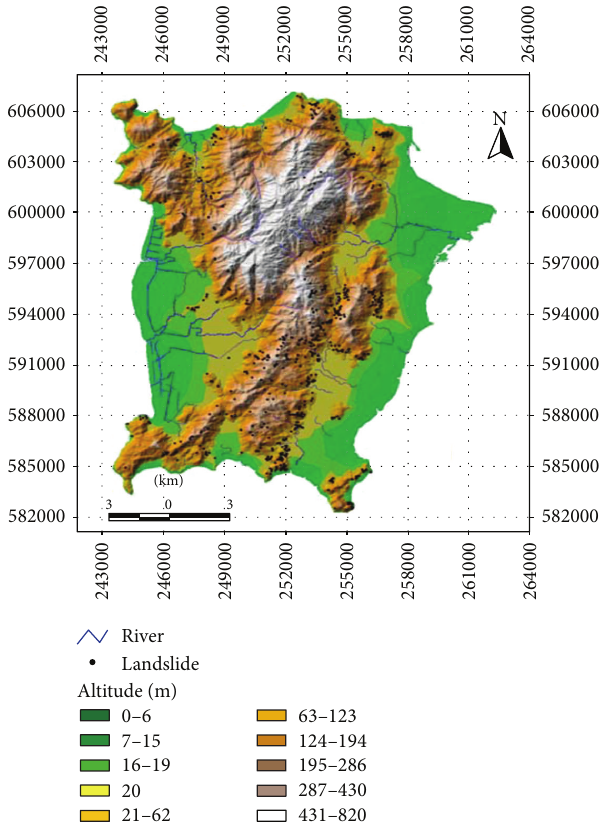
Figure 1: Study area map and landslide location map with hill shaded